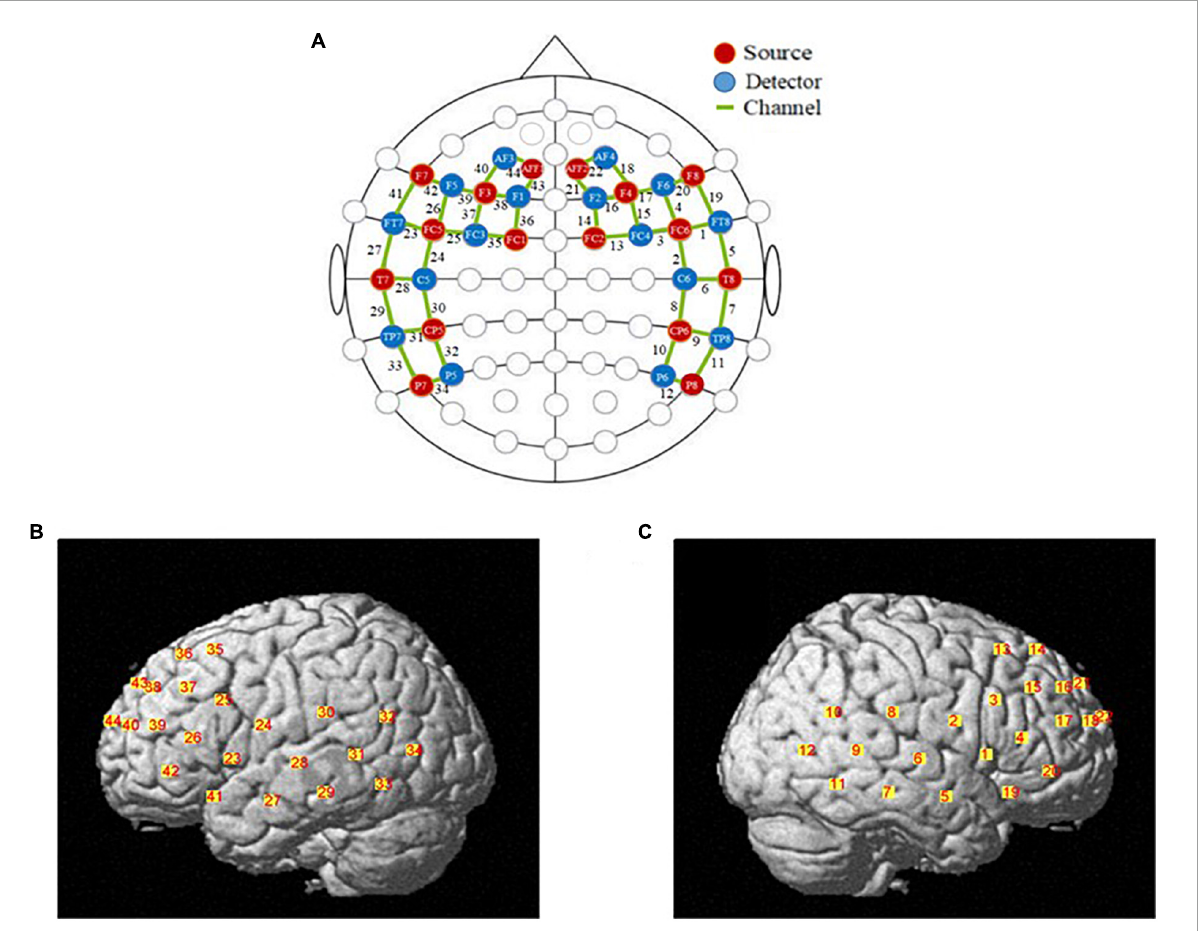
FIGURE1 The locations of optodes and channels. (A) The locations of optodes and channels with respect to the EEG 10/20 system. The locations of sources (red dots) and detectors (blue dots) and 44 channels (green lines). (B) The locations of optical sources and detectors on a standardized 3D head on left view. (C) The locations of optical sources and detectors on a standardized 3D head on right